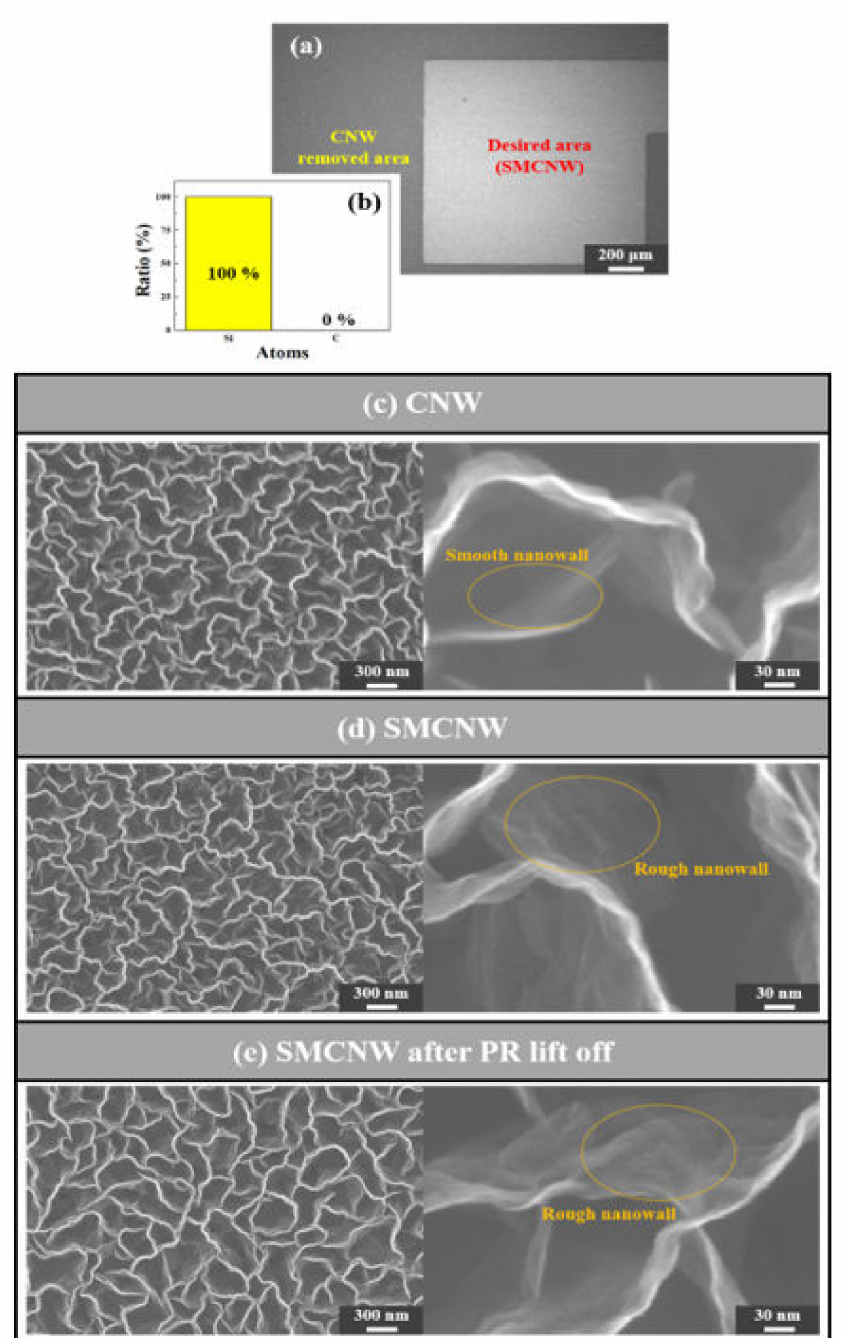
Figure 6. ( a ) FESEM surface image after applying the top-down surface micromachining technology to the SMCNW. ( b ) EDS analysis of the area where the CNW was removed through ultrasonic cleaning. FESEM surface image of the ( c ) CNW, ( d ) SMCNW, and ( e ) PR-removed